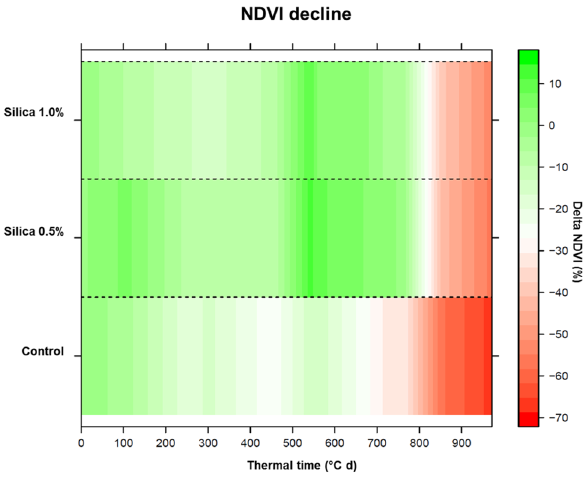
Figure 2. Heatmap plot of average measured NDVI decline (in %; based on average initial NDVI measurement; linear interpolated) over thermal time (°C d) for the different treatments (control, 0.5% ASi and 1%